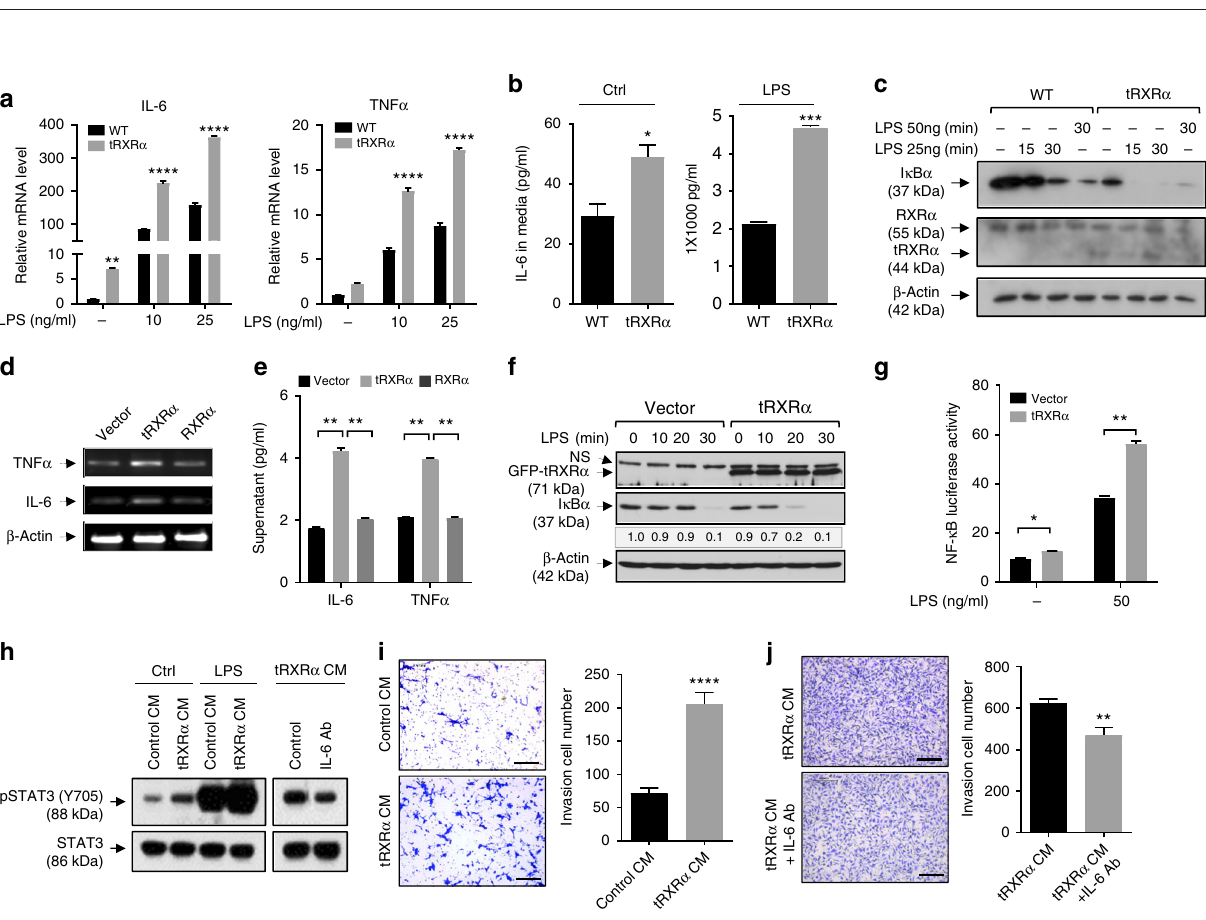
Fig. 4 Myeloid-speci fi c truncated retinoid X receptor α expression is necessary for signal transducer and activator of transcription factor 3 activation and colorectal carcinogenesis. a Tumor size from mice treated with azoxymethane (AOM)/dextran sodium sulfate (DSS) for 4 months. Each dot represents a tumor. Data are mean ± SD ( n = 6), one-way analysis of variance (ANOVA). b Tumor size distribution. Data are mean ± SEM ( n = 6), two-way ANOVA. c Colon tumor sections from mice treated with AOM/DSS for 4 months were stained with hematoxylin and eosin, Scale bars, 100 μ m, and classi fi ed into normal, low-grade, and high-grade lesions based on histological analysis ( n = 6). Data are mean ± SEM ( n = 6), two-way ANOVA. d Representative CD68 immunostaining image of colonic sections from mice treated with AOM/DSS (scale bars, 50 μ m) and the score of the number of CD68-positve cells per fi eld. Each dot represents a mouse, and 10 fi elds were counted per mouse. Data are mean ± SD ( n = 6), one-way ANOVA. e Relative mRNA expression levels of the indicated genes in colon of mice treated with AOM/DSS were determined by quantitative reverse transcriptase – PCR. Data are mean ± SEM ( n ≥ 4). one-way ANOVA. f Colon lysates from mice treated with AOM/DSS were analyzed by immunoblotting. The bands are quanti fi ed with Image J and normalized to β - actin. One of three similar experiments is shown. * P < 0.05, ** P < 0.01, *** P < 0.001